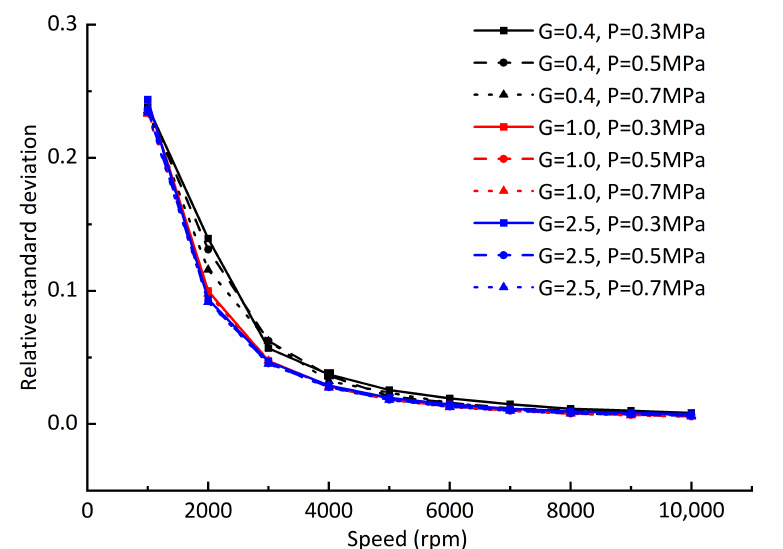
Figure 12. Relative standard deviation of dynamic equilibrium position offsets at different rotat- ing speeds.